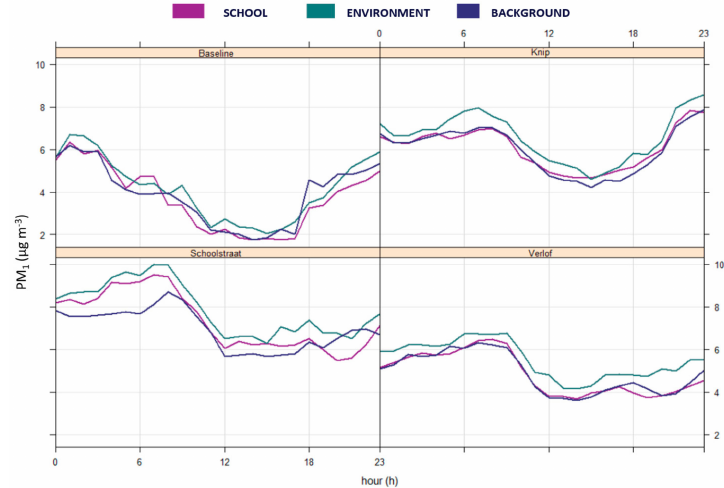
Figure 7. Average hourly NO 2 (upper), NO (middle) and PM 1 (lower) concentration ( µ g m − 3 ) variability throughout the day (0–23 h), plotted for each monitoring location (school, environment and background) and implemented traffic scenario (baseline, knip, schoolstreet and school holi- days